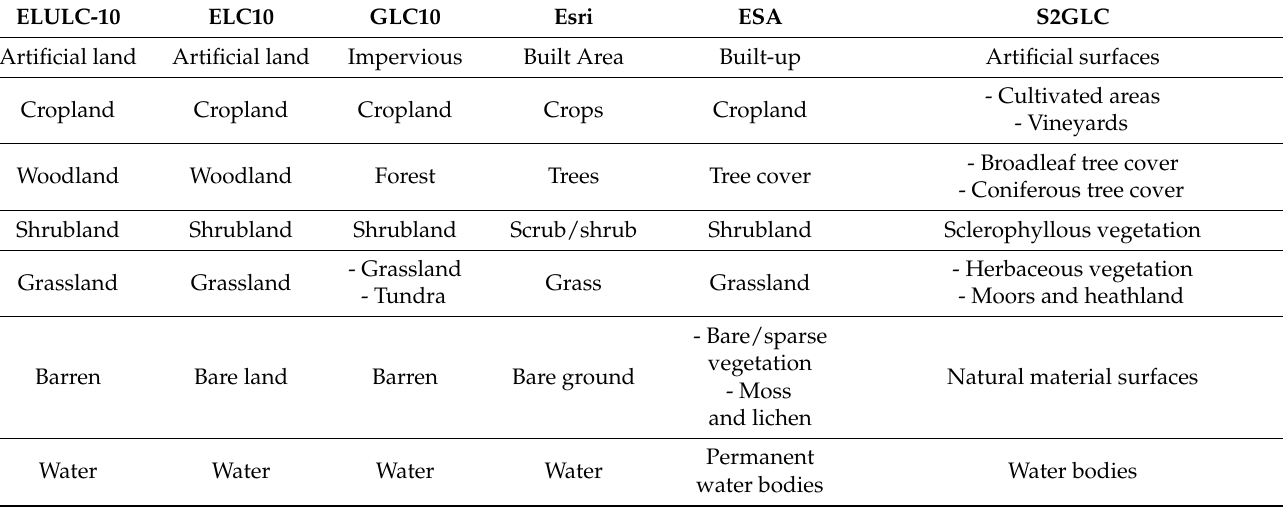
Table A1. The reclassified classes of the available 10 m maps for the comparison